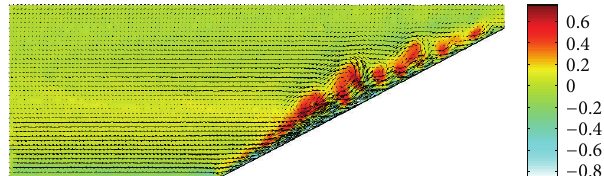
Figure 2: Eulerian velocity fields and vorticity map (the vorticity unit is s −1